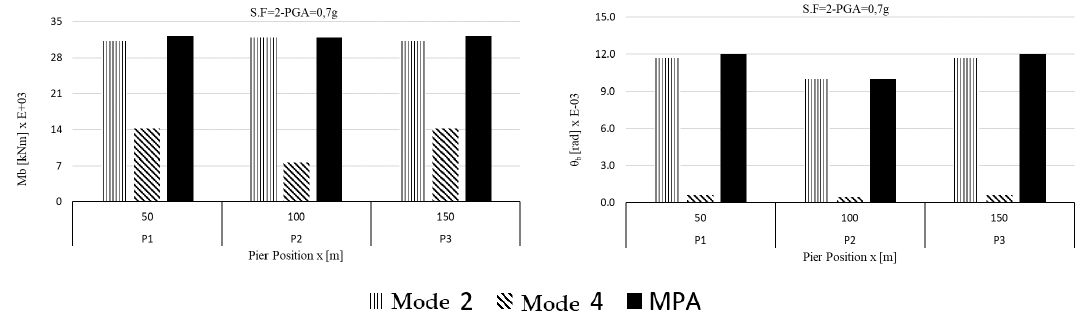
Figure A1. Regular bridge—bending moment (M b ) and curvatures (q b ) at the hinge location, derived by performing nonlinear dynamic analysis and modal pushover according to each single mode (PGA from 0.175 to 0.7 g).